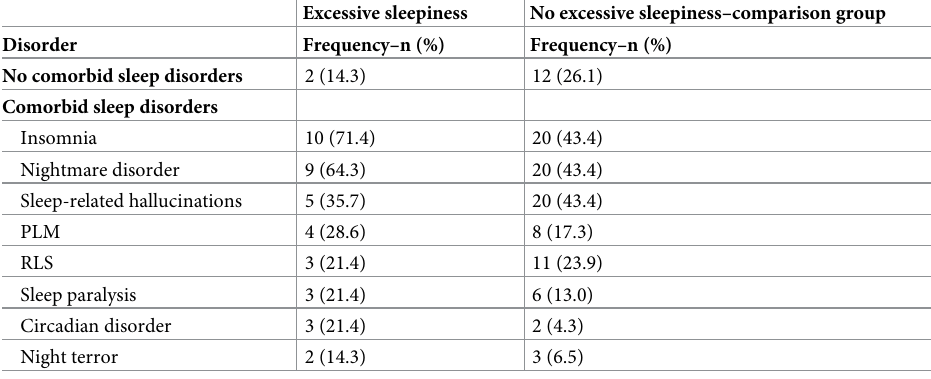
Table 3. Comorbid sleep disorders in excessive sleepiness and comparison